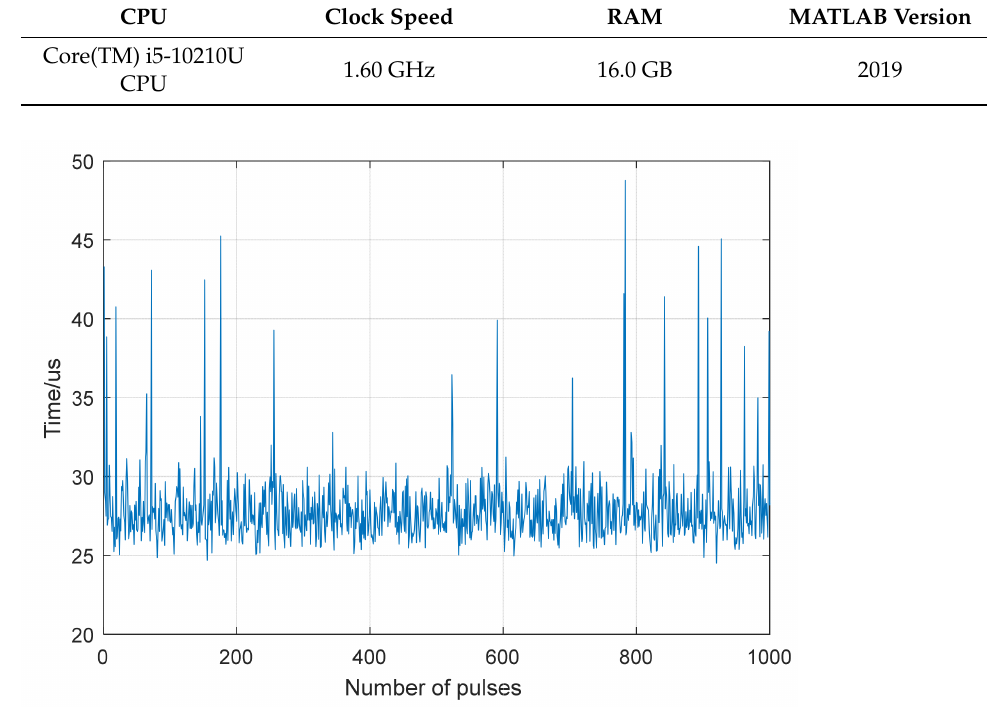
Figure 6. Running time calculation.